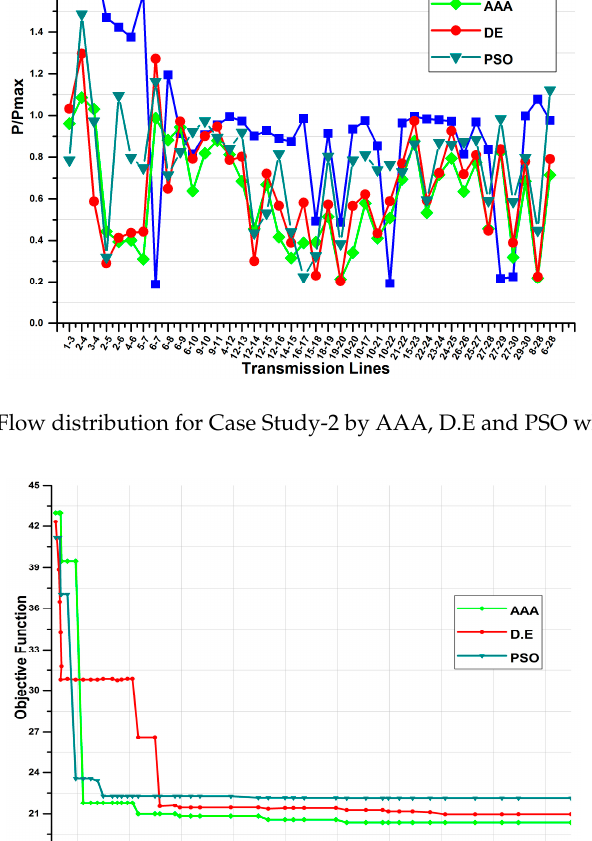
Figure 9. Convergence Curve of the objective function by AAA, D.E and PSO for Case Study-2 (line 1 trip).